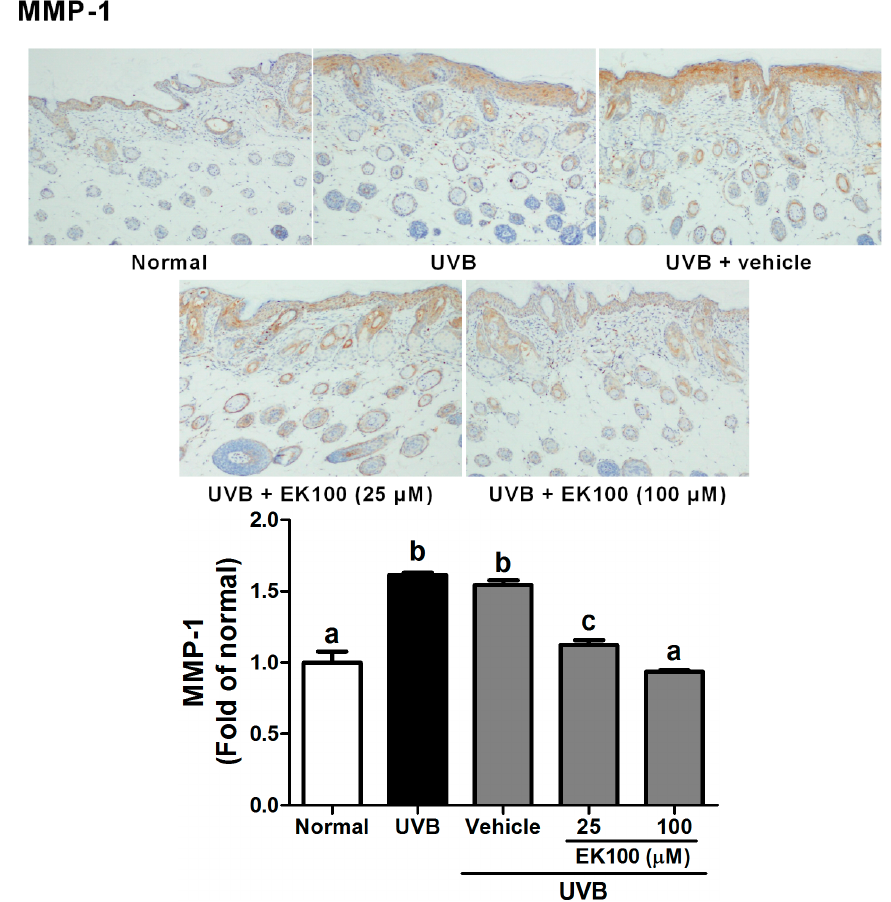
Figure 6. Immunohistochemical staining of MMP-1 expression in mouse skin slices. EK100 inhibited the UVB-induced overexpression of MMP-1. UVB irradiation increased the MMP-1expression and EK100 treatment reduced the MMP-1 level. a–c : Values not followed by a common letter are significantly different ( p < 0.05).